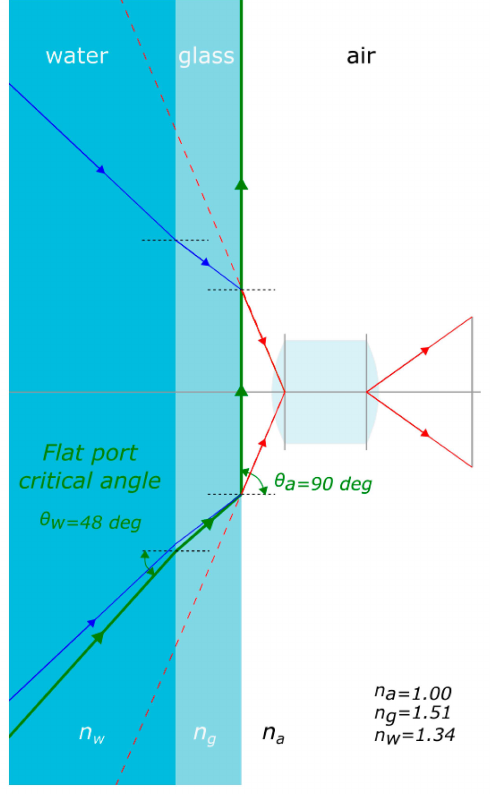
Figure 3. In a flat port the maximum field of view is limited by the total internal